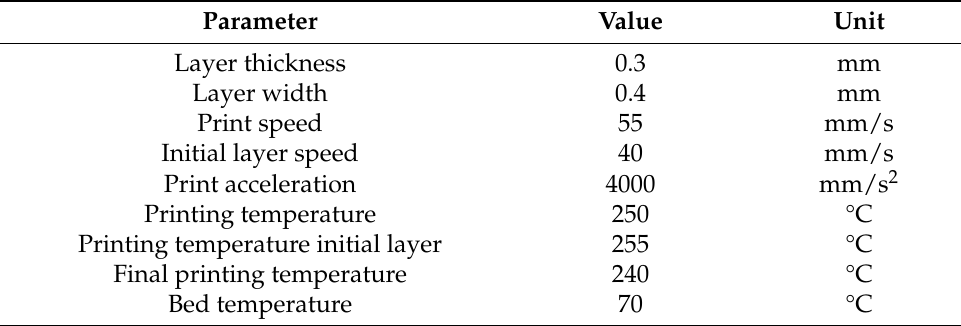
Table 2. Process parameters of 3D printing.